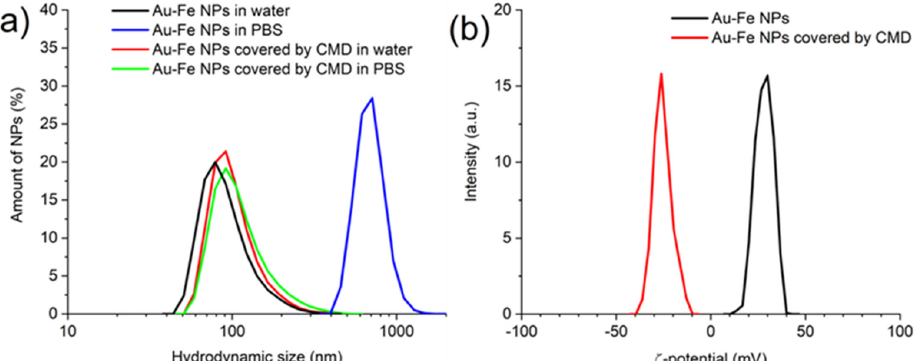
Figure 4. ( a ) DLS size histograms of the core-satellite Au-Fe NPs after incubation for 24 h in water and PBS. Black curve—bare NPs incubated in water, blue curve—bare NPs incubated in PBS, red curve—CMD covered NPs incubated in water, green curve—CMD covered NPs incubated in PBS. ( b ) ζ -potential of bare (black) and CMD covered (red) core-satellite Au-Fe NPs.